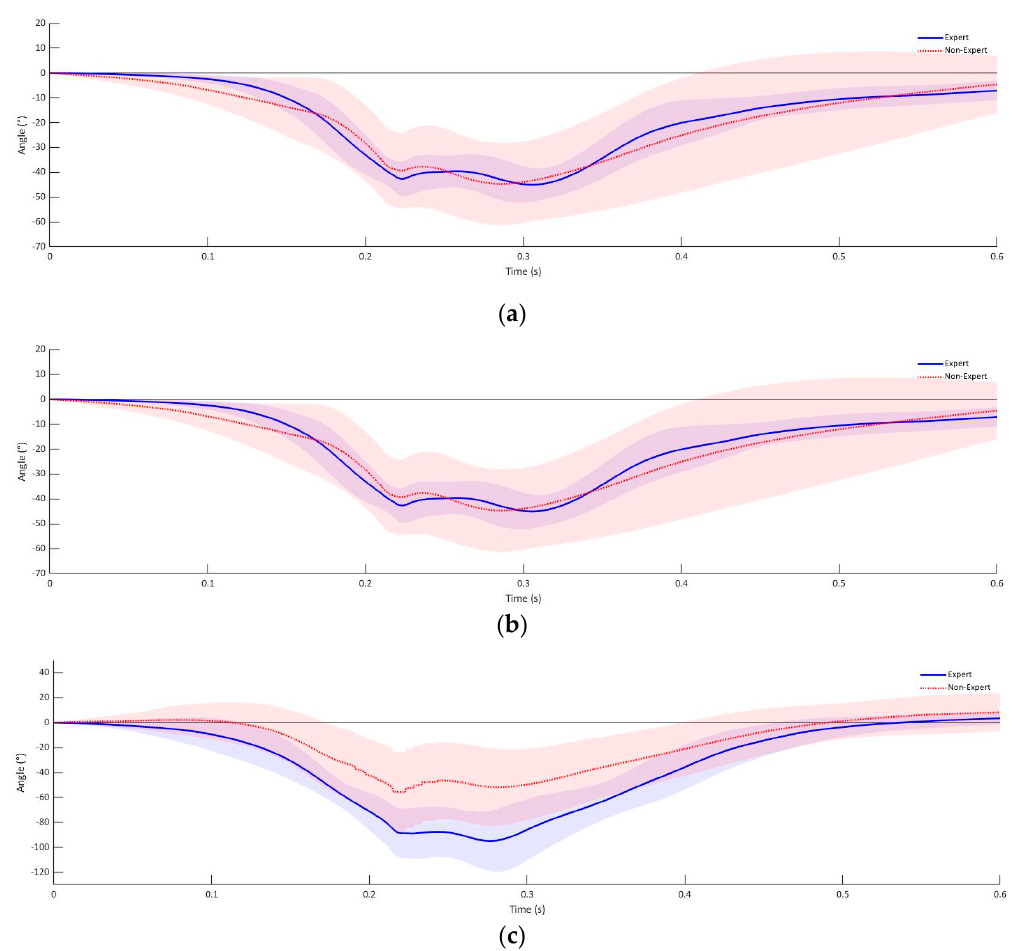
Figure 4. Fist rotation experienced athletes cross punch: ( a ) longitudinal, ( b ) transversal and ( c ) sagittal axis. After impact, the fist is immediately returned to the defensive position. Table 2 shows a mean deviation of the orientation of the fist in three-dimensional space from the initial to the retracted position of − 4.24 ◦ (SD = 3.85 ◦ ) in the longitudinal axis, − 1.92 ◦ (SD = 4.33 ◦ ) in the transverse axis and − 0.17 ◦ (SD = 6.42 ◦ ) in the sagittal axis of the